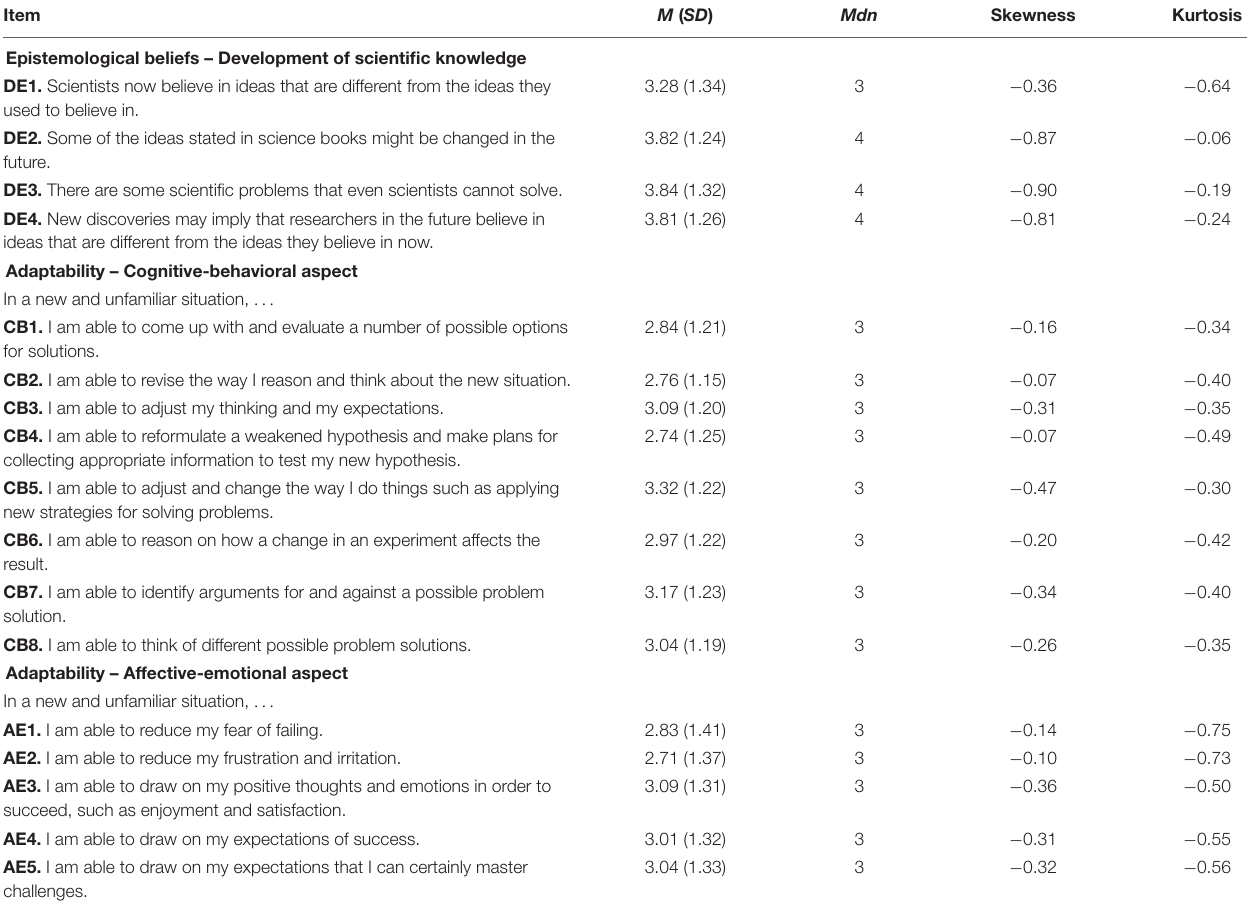
TABLE 1 | Item wordings, descriptive statistics, medians, skewnesses, and kurtosis of the epistemological beliefs and adaptability items. Item M ( SD ) Mdn Skewness